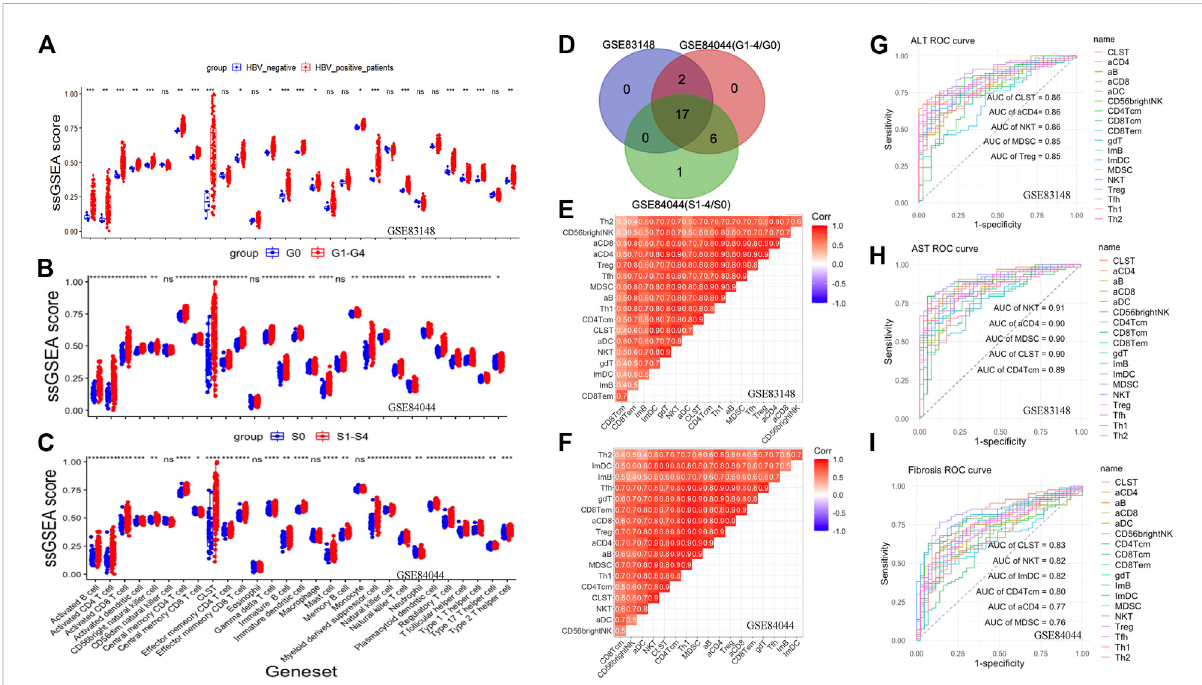
FIGURE 2 Co-enrichment and diagnostic values of CLST, NKT, MDSC, and aCD4 in CHB and HBV-LF. (A) Boxplot comparing immune signals between patients with chronic HBV infection and normal tissues from patients without HBV infection. (B) Boxplot comparing immune signals between patientswithin fl ammation(G ≥ 1)andthosewithoutin fl ammation(G=0). (C) Boxplotcomparingimmunesignalsbetweenpatientswithliver fi brosis (S ≥ 1) and those without liver fi brosis (S = 0). (D) Venn diagram of upregulated LILs. (E,F) Correlation heatmap showing the co-enrichment pattern of CLST and LILs in CHB and HBV-LF. (G – I) ROC curves of CLST and LILs for predicting liver injury and